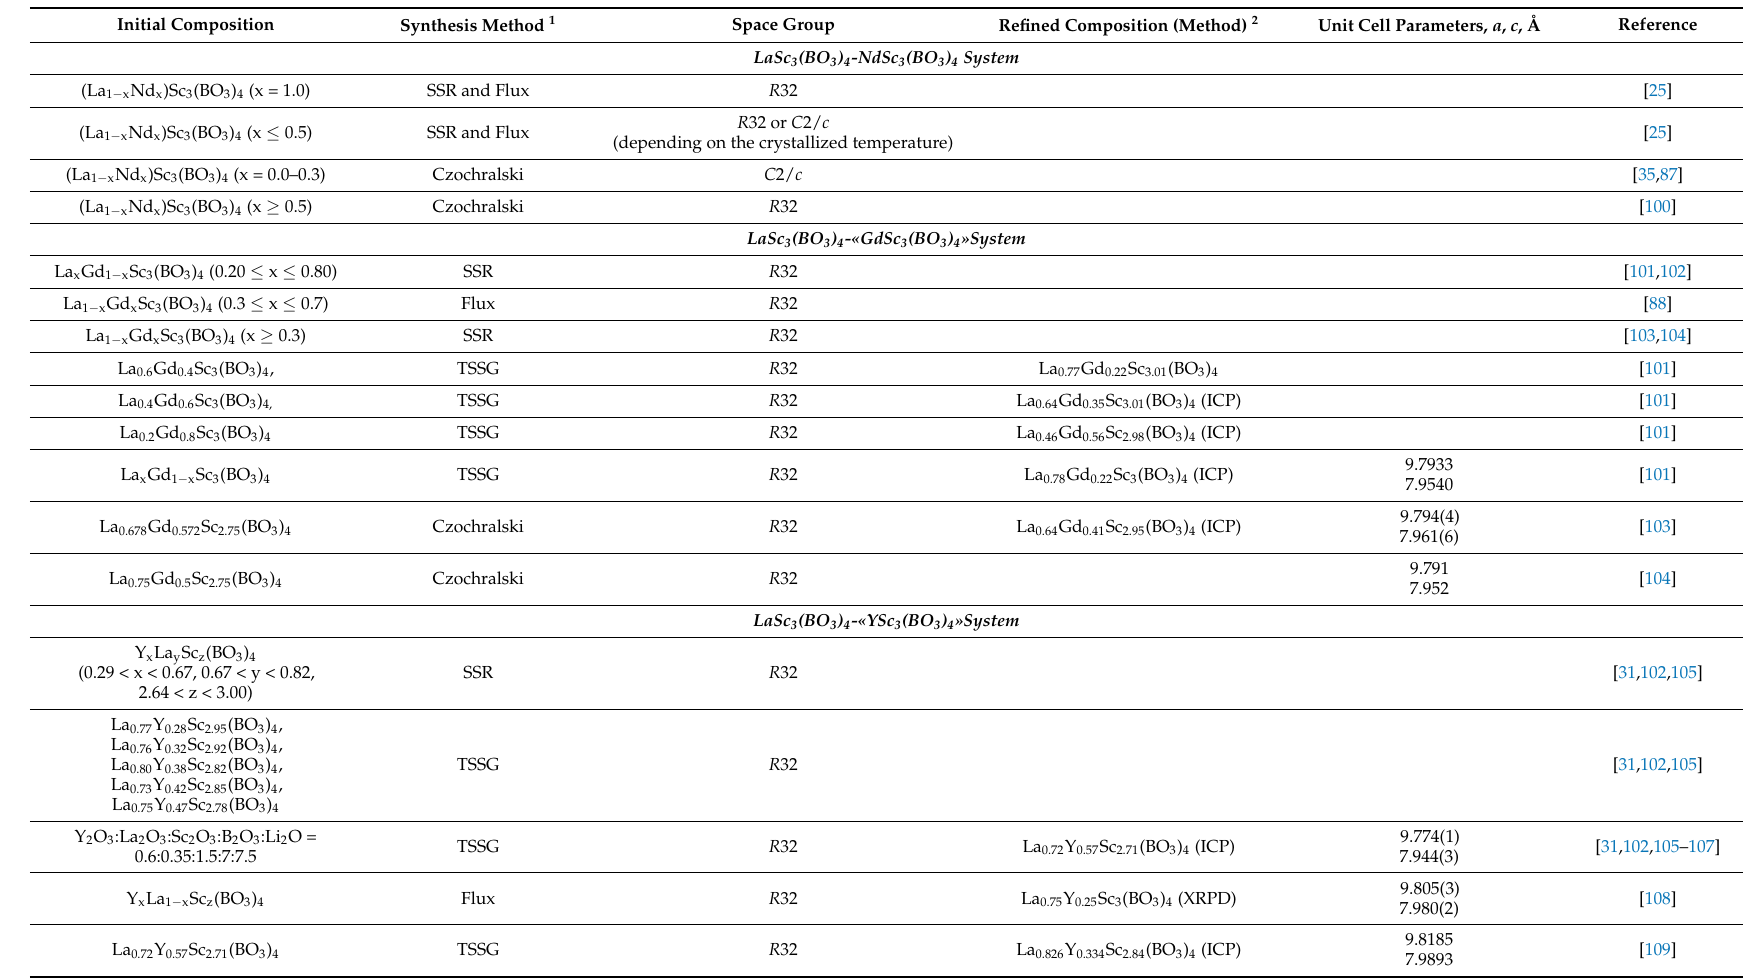
Table 2. Summary structural data on solid solutions of rare-earth scandium